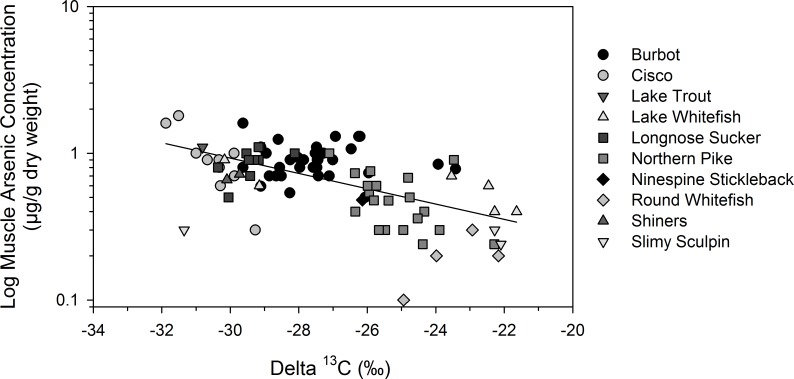
Correlation between muscle total arsenic concentration and carbon source (δ13C) in fishes.Data are for the farfield area (r2 = 0.33, p < 0.001, n = 92) in Great Slave Lake, Northwest Territories, Canada. Total arsenic concentrations are presented on a logarithmic scale, and individual fish species are identified. One muscle sample outlier was not included.